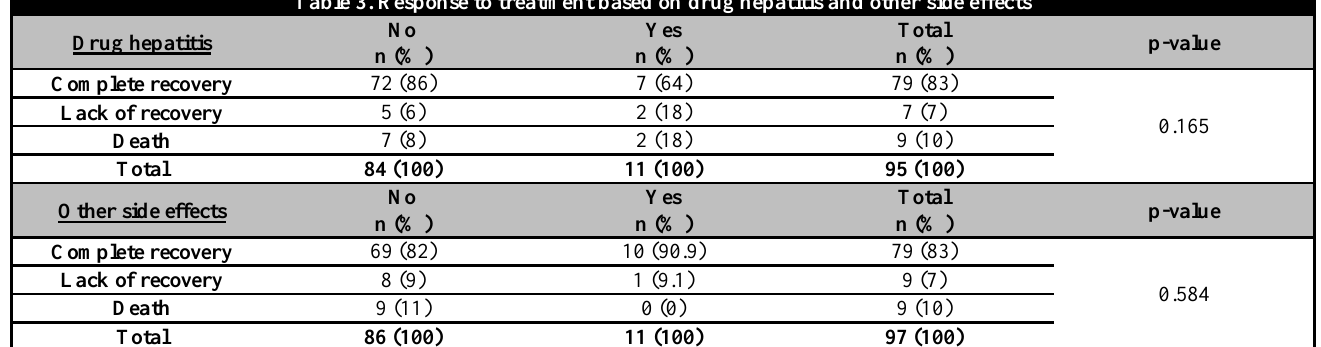
Table 3. Response to treatment based on drug hepatitis and other side